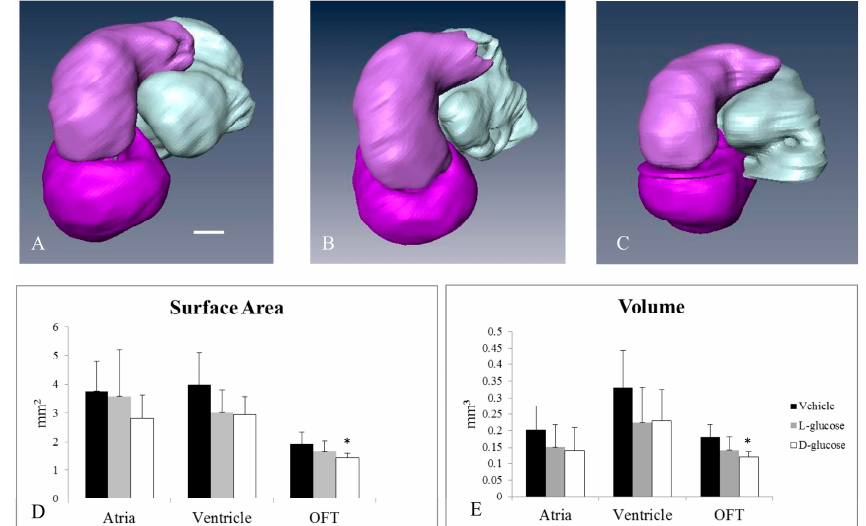
Figure 4. Micro-CT analysis of HH24 hearts reveals differences in endocardial OFT properties in response to hyperglycemia. Representative, reconstructed micro-CT images of the atria (white), ventricle (dark purple), and OFT (light purple) for a vehicle control ( A ), an osmotic control ( B ), and a D -glucose-treated embryo ( C ). The average surface area ( D ) and volume ( E ) for the heart sections. Scale bar = 100 µm. * p < 0.05 ANOVA.